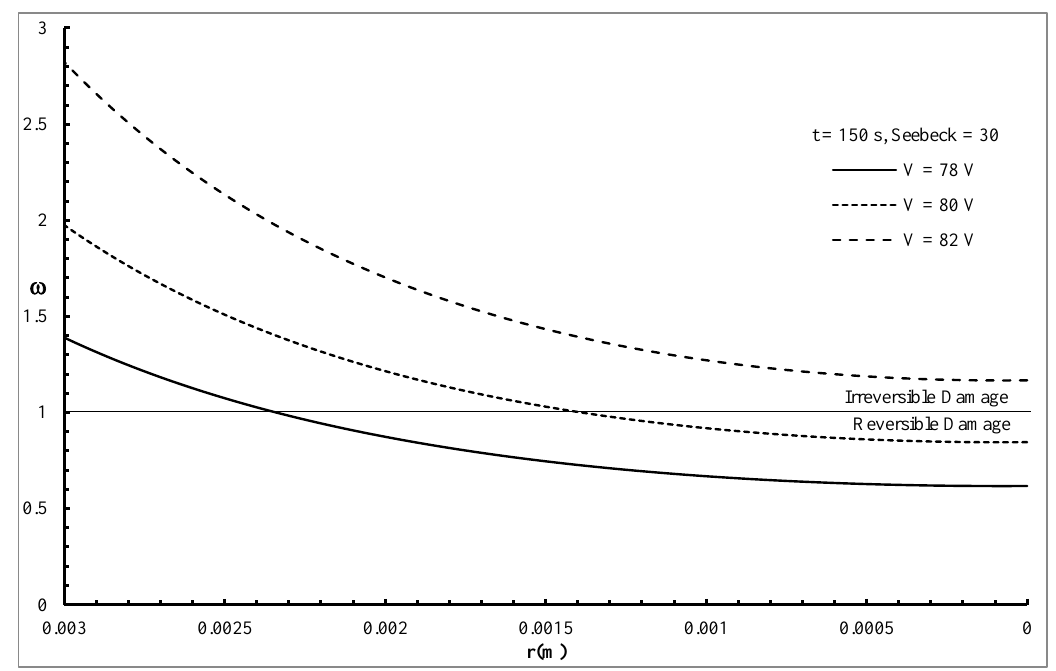
Figure 11 . The thermal damage distribution of myxoid liposarcoma tumor with various values of R   . voltage when 75 e